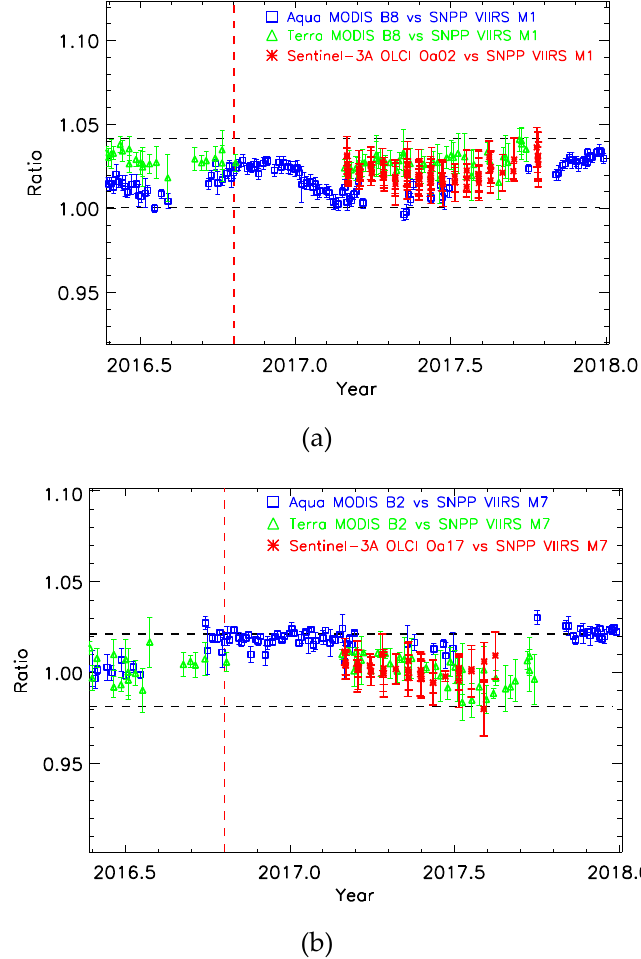
Figure 20. The radiometric comparison time series, from May 2017 to September 2017, of (a) MODIS B8 and Sentinel-3A OLCI Oa02 versus SNPP VIIRS M1 and (b) MODIS B2 and Sentinel-3A OLCI Oa17 versus SNPP VIIRS